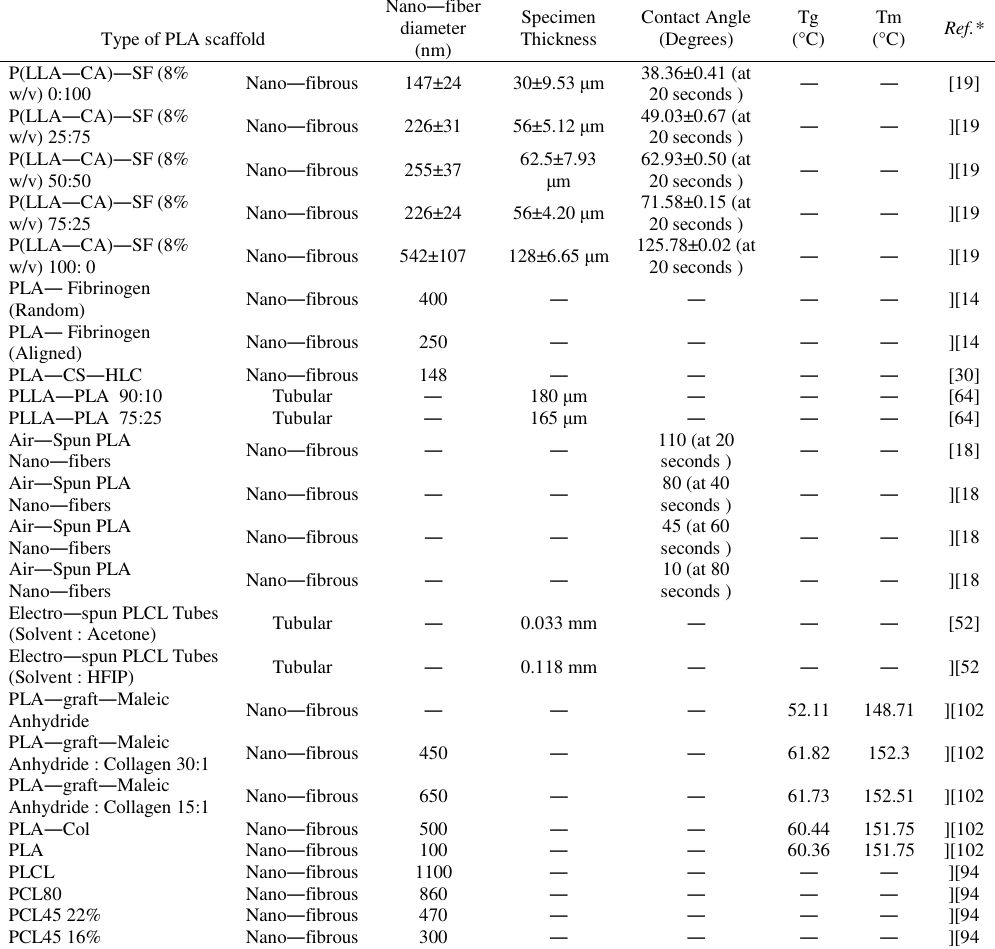
Table 5 : Basic features of the PLA vascular